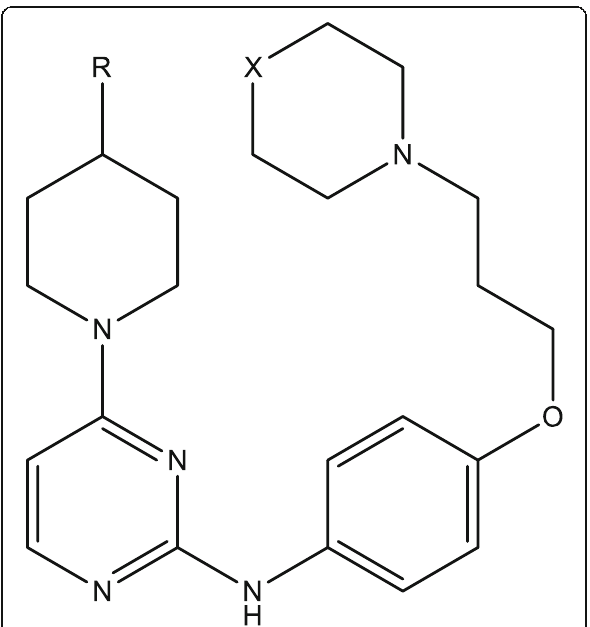
Fig. 1 Parent compound of 2-anilinopyrimidine derivatives